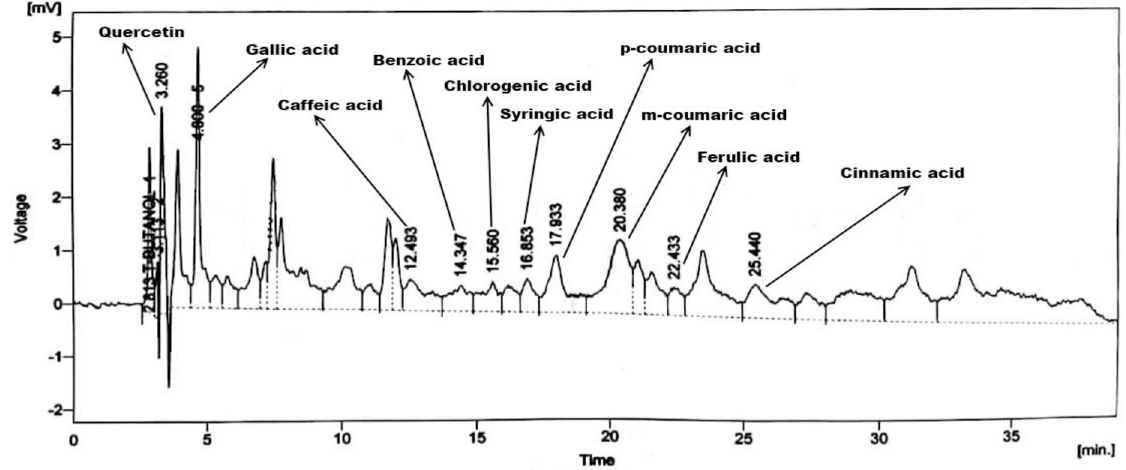
Fig 5. HPLC chromatogram of the Euphorbia nivulia Buch.-Ham. butanol extract.